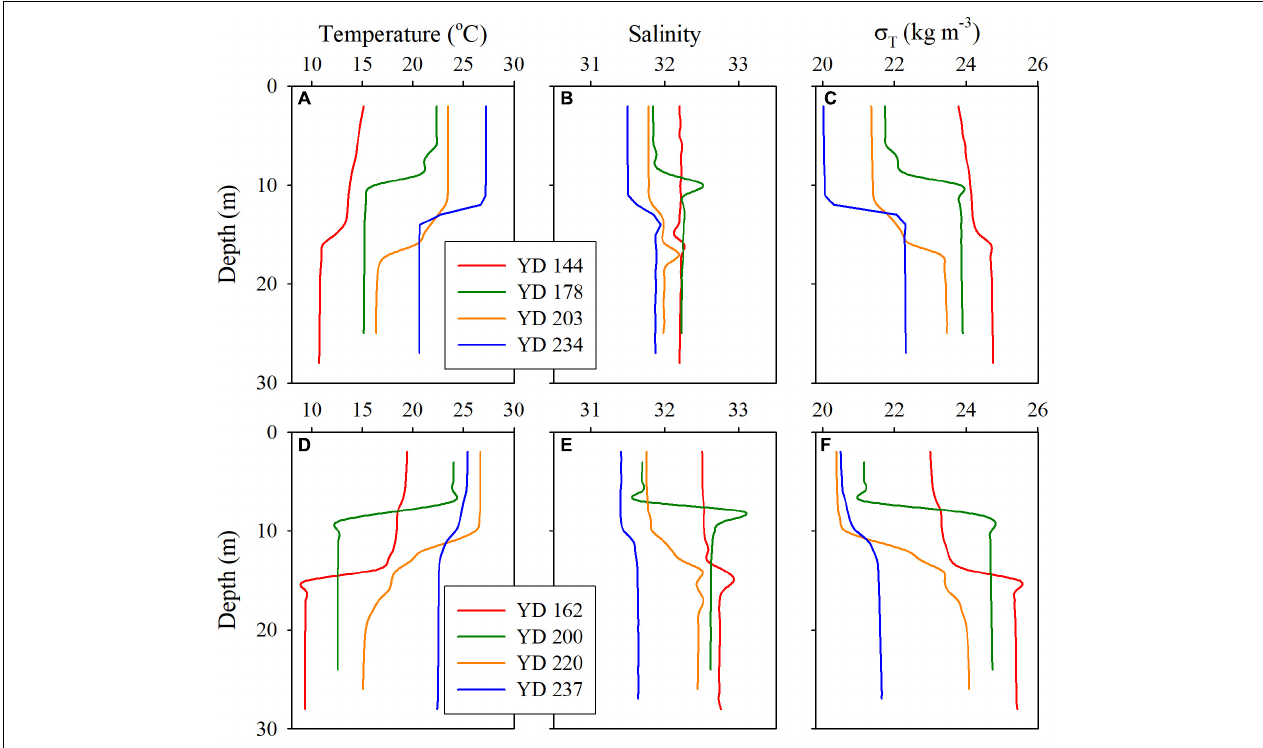
FIGURE 2 | Vertical profiles of temperature (A,D) , salinity (B,E) , and density (C,F) for each cruise at station A5 in 2017 (upper panels) and 2018 (lower panels).